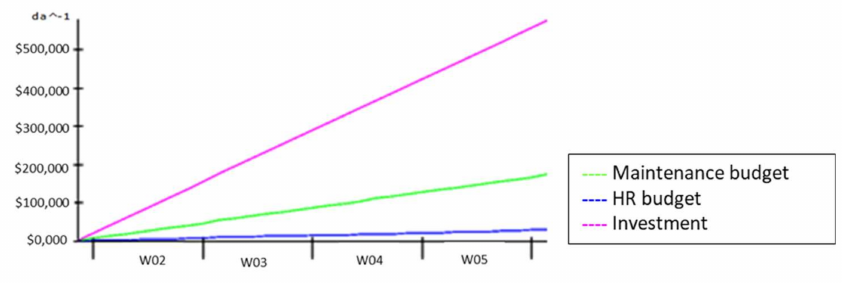
Figure 13. Zoom on ordinary economic value.